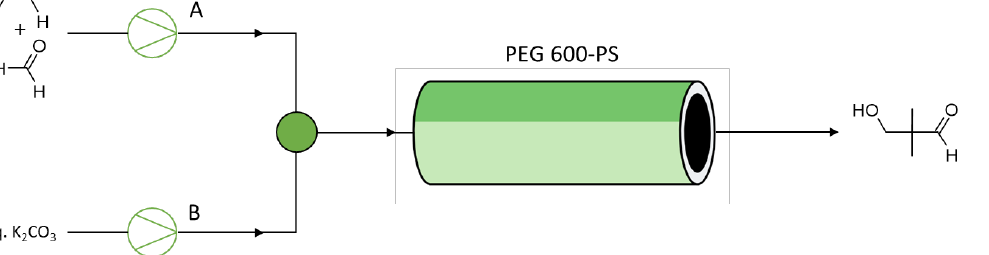
Scheme 4. HPA synthesis in a flow reactor. Reaction conditions: IBA:FA molar ratio 1.2:1; 40 wt.% K 2 CO 3; PEG 600-PS, 0.5 mol%; 600 rpm; 40 ◦ C, 2 h.